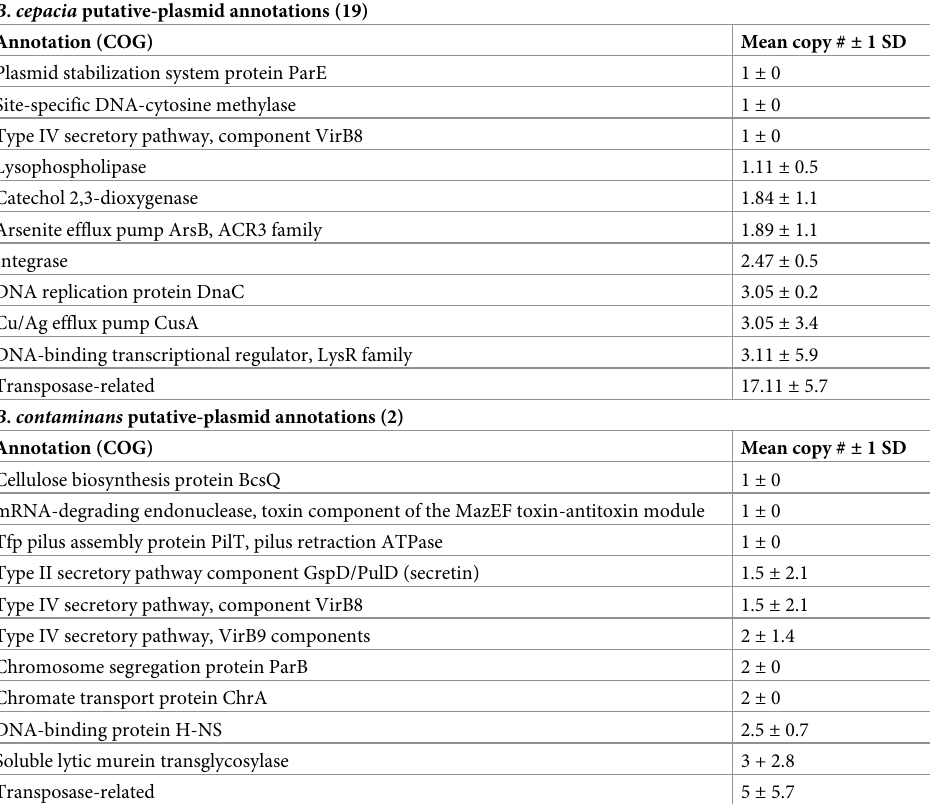
Table 5. COG functional annotations and copy numbers per putative plasmid for B . cepacia and B . contaminans